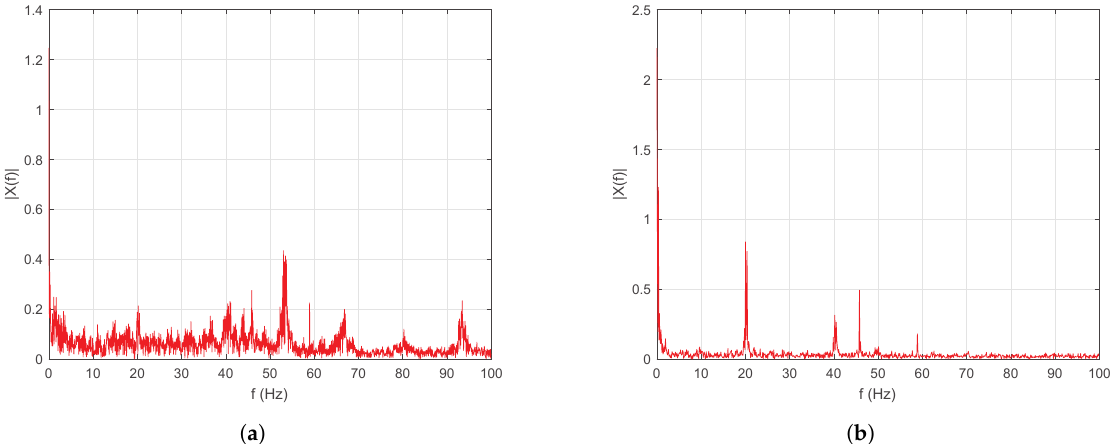
Figure 13. Response of accelerometer with the Fast Fourier Transformation (FFT) applied. ( a ) Input step without the GA. ( b ) Trapezoidal velocity profile applying the